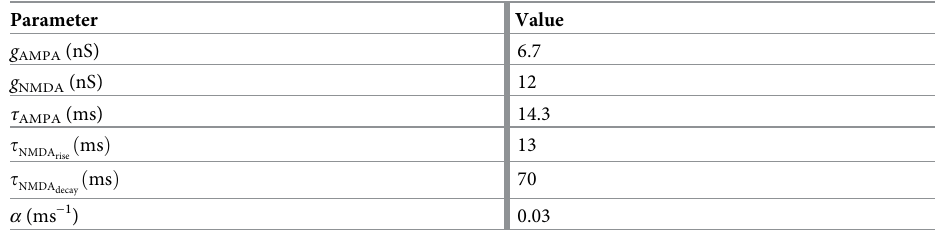
Table 3. External input